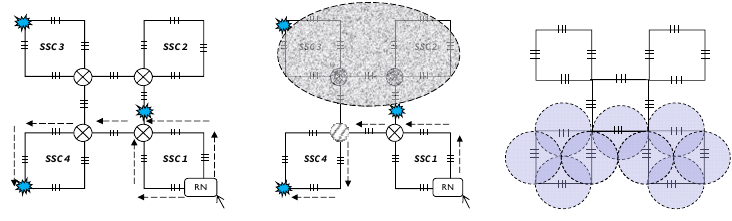
Figure 15. Sensing coverage under three failures.